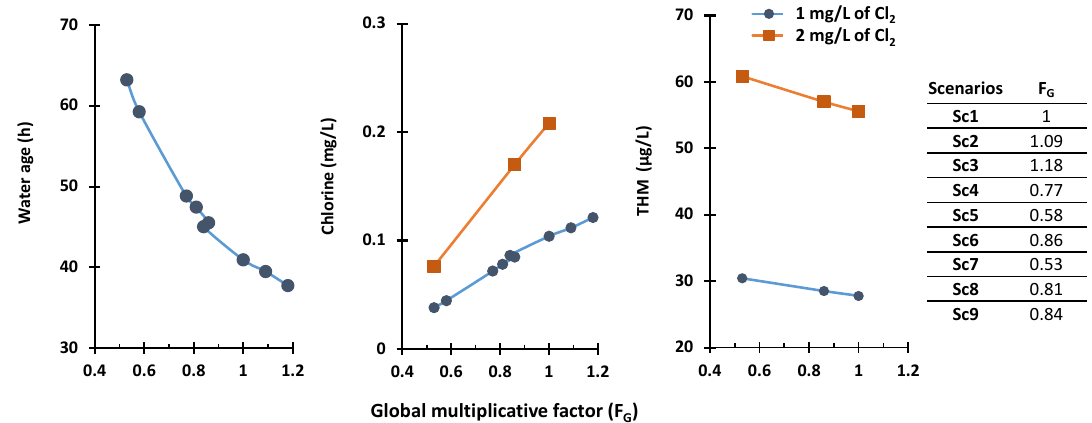
Figure 8. Water quality variations (water age, chlorine residuals, THMs) in different scenarios based on the global demand multiplicative factor corresponding to each scenario, for 1 and 2 mg/L free chlorine residuals at the WTPs’ outlet. The 95th percentile of nodal maximum water age and THM concentration and the 5th percentile of nodal minimum free chlorine level of all